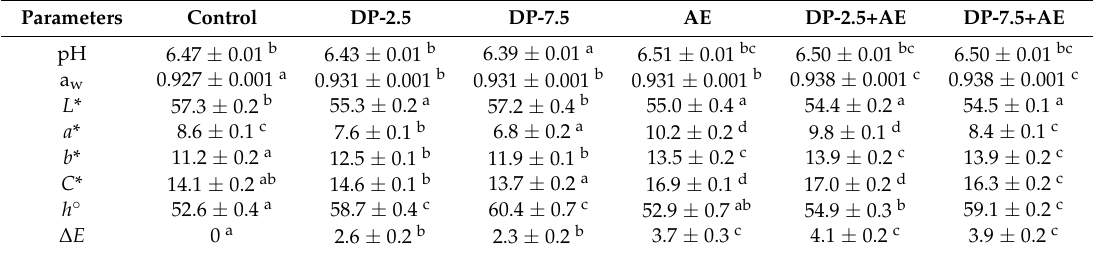
Table 2. Physicochemical parameters (pH, water activity, and colour) of the different p â t é s with date paste (DP) (0%, 2.5% and 7%) and annatto extract (AE) (0 and 128 mg/kg) (Mean ±